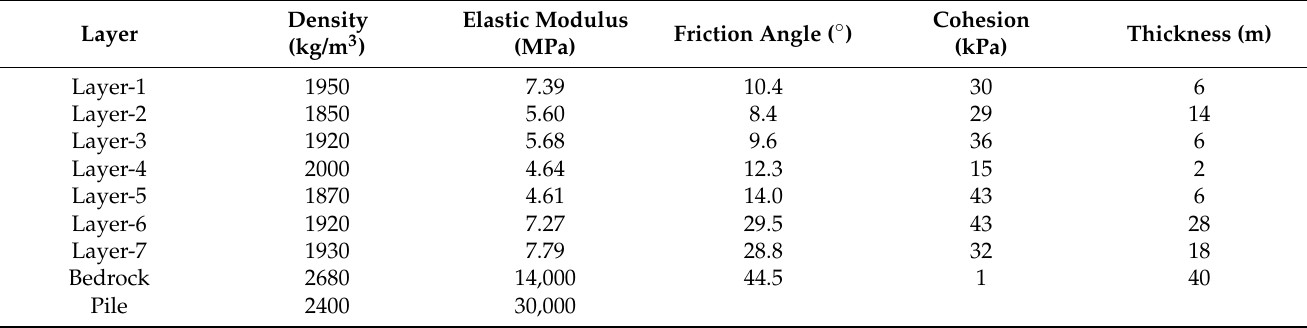
Table 2. Material parameters of soil and pile.